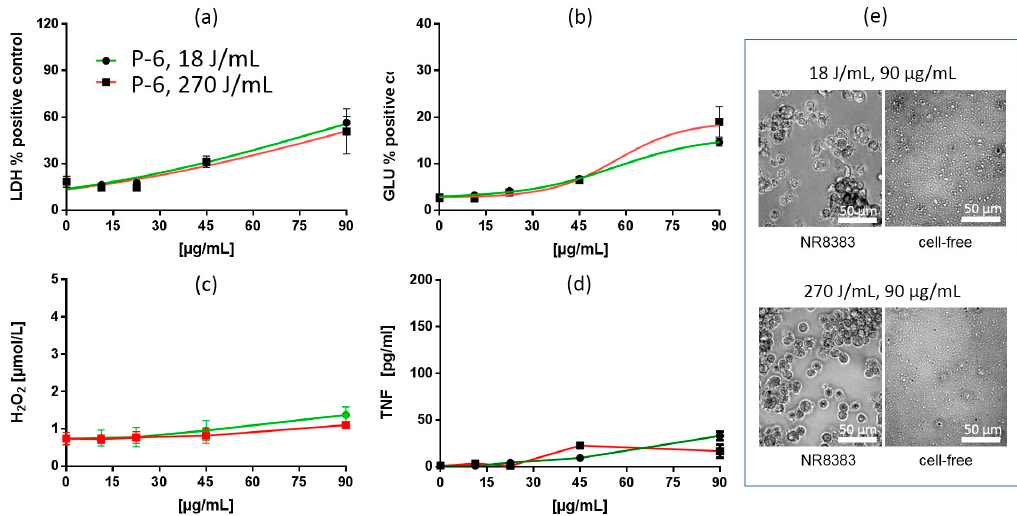
Figure 3. In vitro response of NR8383 alveolar macrophages to precipitated silica P-6. Particles were dispersed with either 18 J/mL (green) or 270 J/mL (red). ( a ) lactate dehydrogenase activity (LDH), ( b ) glucuronidase activity (GLU), ( c ) H 2 O 2 concentration, and ( d ) tumor necrosis factor alpha (TNF). ( e ) NR8383 cells after 16 h exposure to P-6, dispersed with 18 J/mL or 270 J/mL; right panels show particles settled onto the bottom of culture well under cell-free conditions. P-6-treated cells appear dark due to engulfed particles which had been cleared from the area between the cells. Settled P-6 particles dispersed with 270 J/mL appear smaller than particles dispersed with 18 J/mL